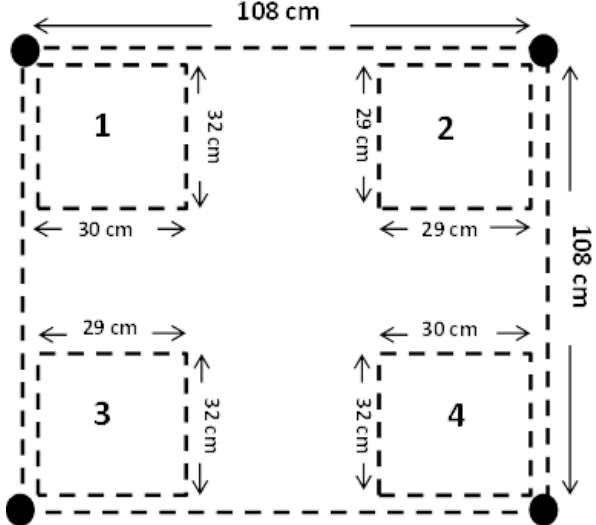
Fig. 2. Distribution of the subplots within the rainfall simulator wet- ting